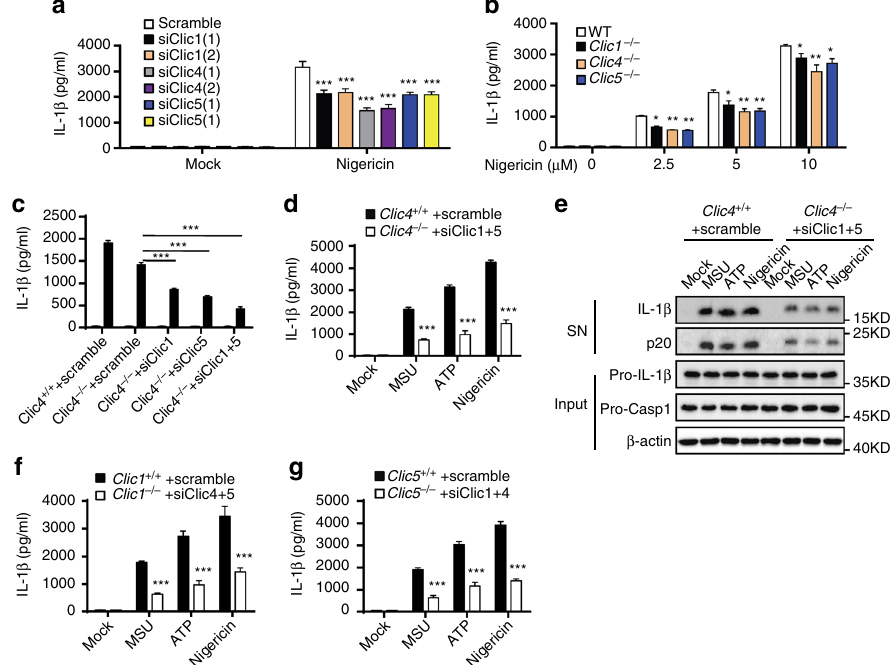
Fig. 2 Inhibition of Clics suppresses NLRP3 in fl ammasome activation. a ELISA of IL-1 β in culture supernatants of LPS-primed BMDMs transfected with siRNA against Clic1, 4, or 5 and left stimulated with nigericin. b ELISA of IL-1 β in culture supernatants of LPS-primed Clic1 – / – , Clic4 – / – , or Clic5 – / – BMDMs stimulated with nigericin. c ELISA analysis of IL-1 β in culture supernatants of LPS-primed wildtype or Clic4 – / – BMDMs transfected with siRNA against Clic1, Clic5 , or both of them and left stimulated with nigericin. d , e ELISA d or Immunoblot e analysis of IL-1 β in culture supernatants of LPS-primed wildtype or Clic4 – / – BMDMs transfected with siRNA against Clic1 and Clic5 , and left stimulated with nigericin, MSU, or ATP. f ELISA of IL-1 β in culture supernatants